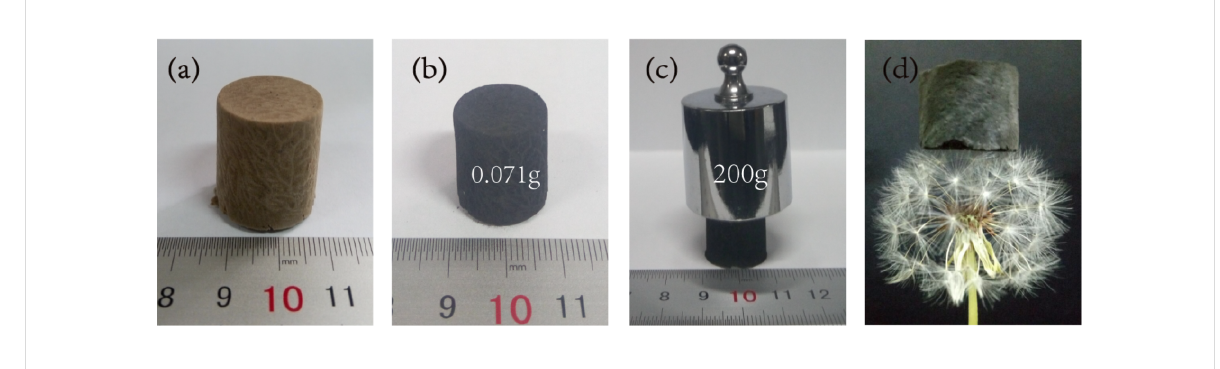
Figure 1: Digital image of (a) CNF/PVA/GO aerogel with dimensions of 1.6 × 1.7 cm; (b) CNF/PVA/GO carbon aerogel with dimensions of 1.5 × 1.6 cm; (c) the carbon aerogel supporting a mass loading of 200 g; (d) the ultralight CNF/PVA/GO carbon aerogel, supported by a